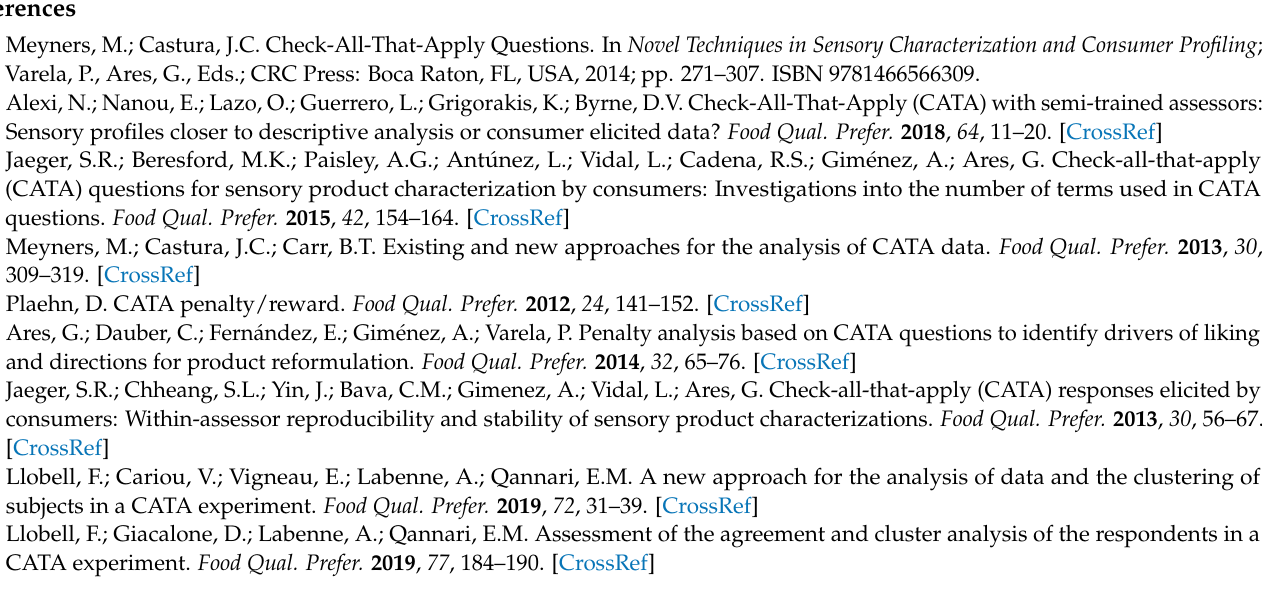
pomace enriched. Figure S3: The heatmap for